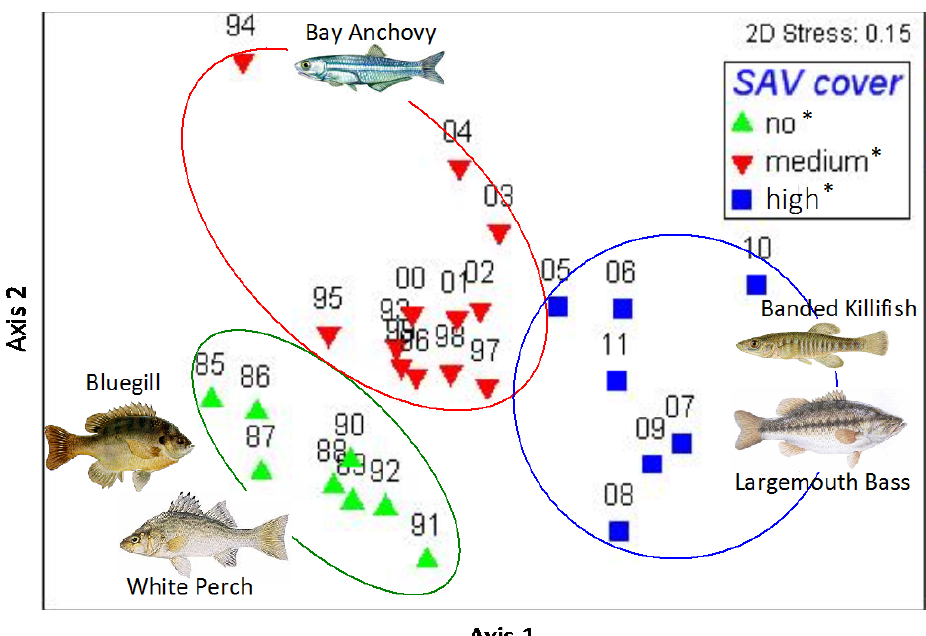
Figure 5. Non-metric multidimensional scaling plot of fish community structure. Each symbol represents the fish community structure in Gunston Cove of one year based on relative abundance. The color-coding of the years represents the amount of SAV cover in those years categorized as ‘no’, ‘medium’, and ‘high’ cover (see Figure 2). The asterisks in the legend indicate that the fish community structure between those three time periods was significantly different from each other. Water 2017 , 9 , 421